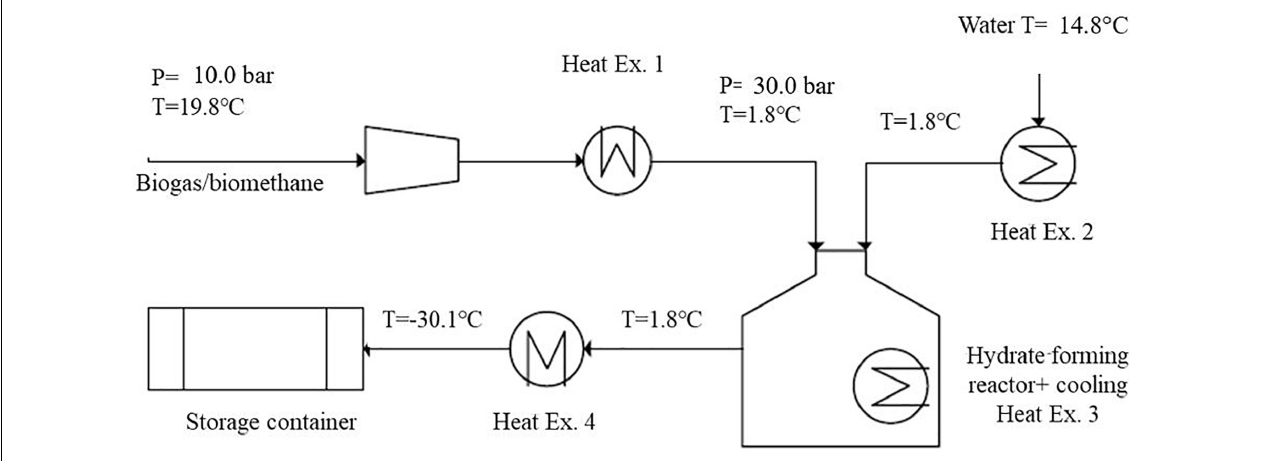
FIGURE 2 | Flow scheme of the hydrate formation processes invoking four heat exchangers (Heat Ex.